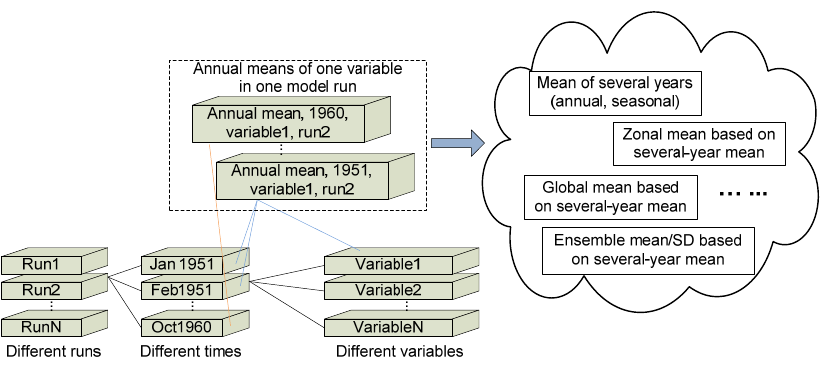
Figure 3. Model simulation data structure and data